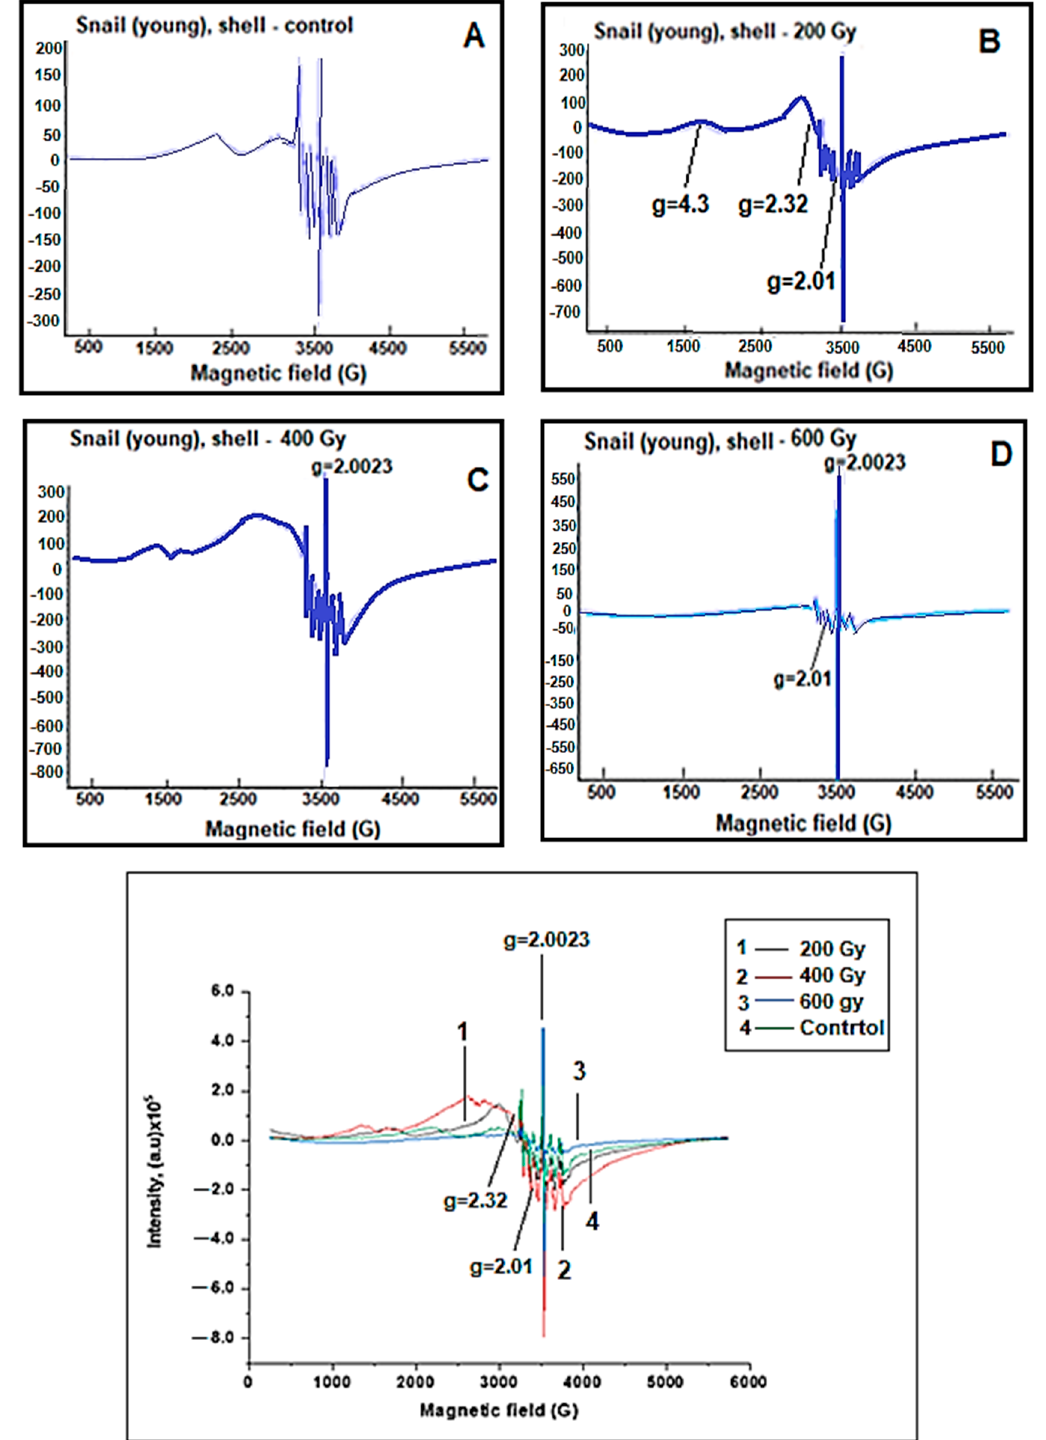
Figure 4. EPR spectra of shell parts of the control and irradiated with different doses of young grape snails. ( A ) Control, ( B ) 200 Gy, ( C ) 400 Gy, ( D ) 600 Gy.